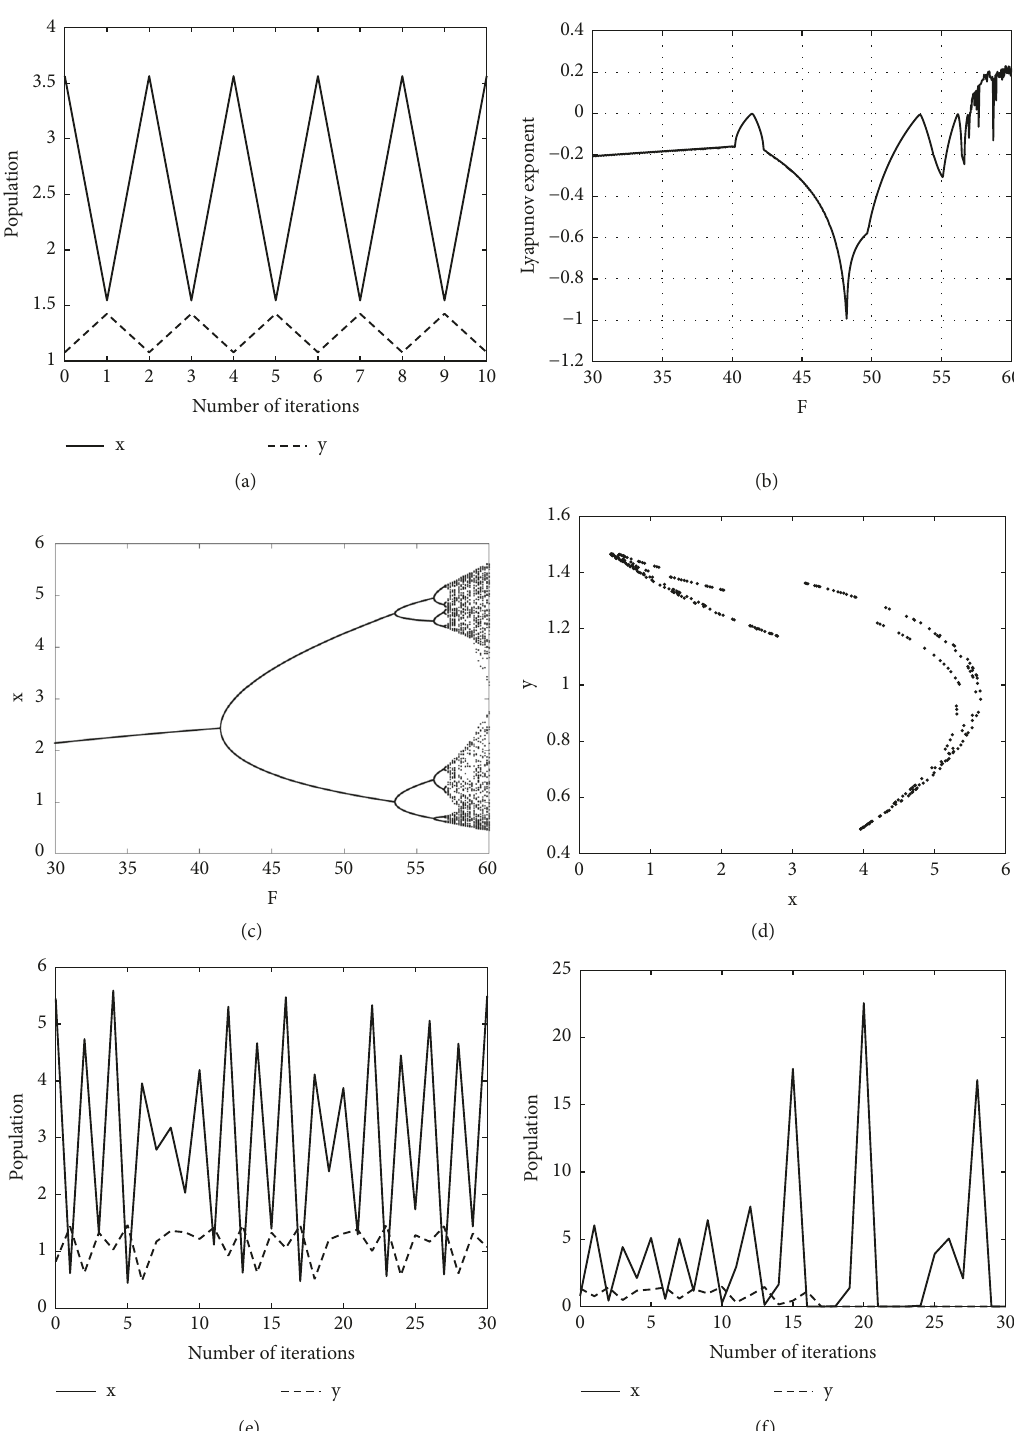
Figure 2: (a) 2-Periodic dynamics generated by (13). Parameter values (𝐹,𝐺) = (45,4) . (b) Values of Lyapunov exponent 𝐿 of orbits generated by (13). 𝐺 = 4 and 30 < 𝐹 < 60 . (c) Bifurcation diagram generated by (13). Same parameter values as in (b). (d) Chaotic dynamics generated by (13). (𝐹,𝐺) = (60,4) . (e) 𝑥 and 𝑦 as functions of time. (𝐹,𝐺) = (60,4) . (f) The route to attractor 𝐴2 . (𝐹,𝐺) = (65,4)